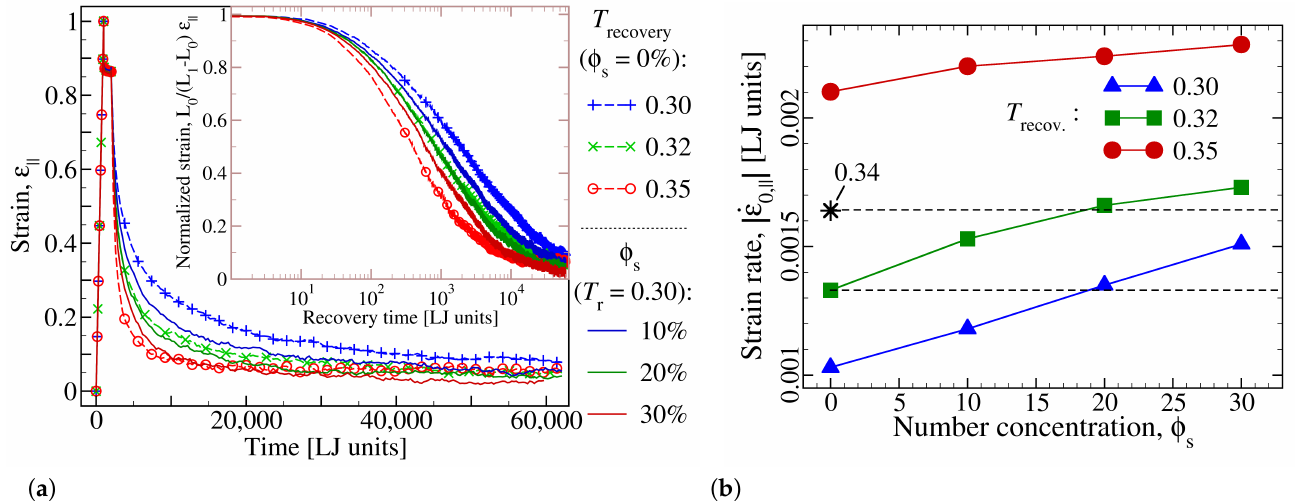
Figure 6. ( a ) Strain versus time for a pure sample ( φ s = 0) at different recovery temperatures and for polymer-additive mixtures at a fixed T recovery = 0.30 for three choices of concentration, φ s (see curve legends) and for additives of size σ SS = 0.5. The presence of additive molecules leads to a higher recovery rate and a lower residual strain. This observation is highlighted further by showing in the inset the same data in log-linear scale. ( b ) The initial strain recovery rate, ˙ (cid:101) 0, (cid:107) , versus additive concentration, φ s , for different recovery temperatures as indicated. The concentration-dependence is more pronounced at lower T recovery . A recovery rate observed in a pure sample at a given temperature can be realized at a lower T if additives are added to the polymer matrix. Two such examples are highlighted by horizontal dashed lines, ( T = 0.34, φ s = 0 ) → ( T = 0.32, φ s ≈ 0.19 ) and ( T = 0.32, φ s = 0 ) → ( T = 0.30, φ s ≈ 0.19 ) . The overlap of the green curves in panel ( a ) is in line with this